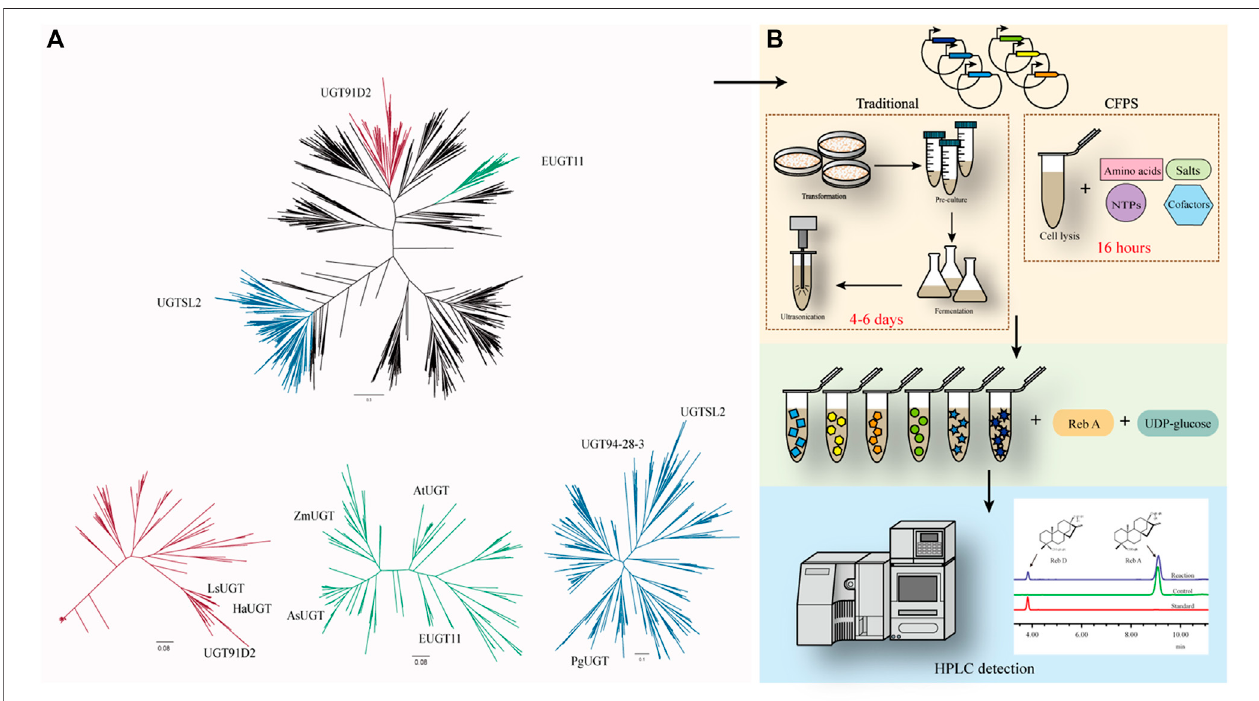
FIGURE 1 | (A) Phylogenetic analysis of UGTs with UGT91D2 as the reference. UGT91D2 is located in the red sub-branch, EUGT11 is located in the green sub- branch, and UGTSL2 is located in the blue sub-branch. (B) Framework for the rapid screening of enzymes with a cell-free protein synthesis system.